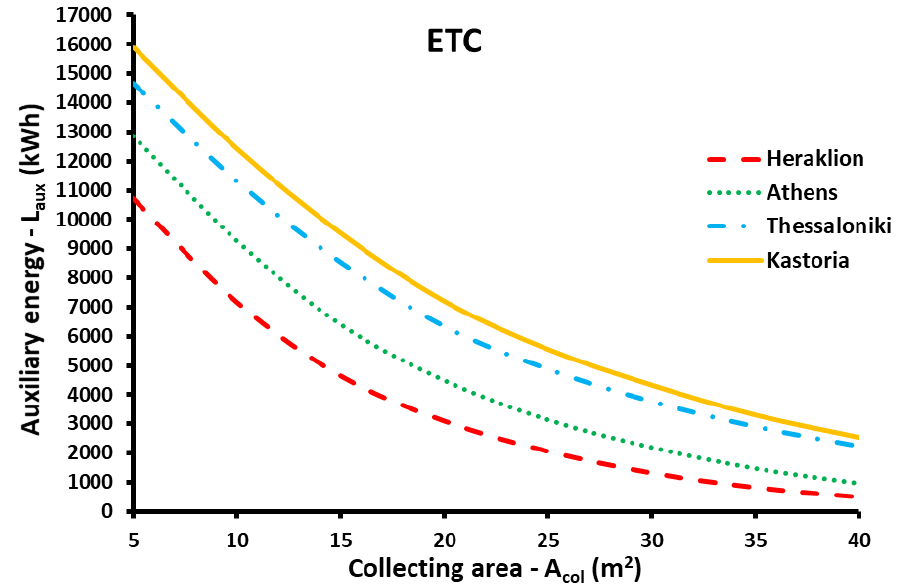
Figure 18. Auxiliary energy consumption with optimum tilt angles for ETC.